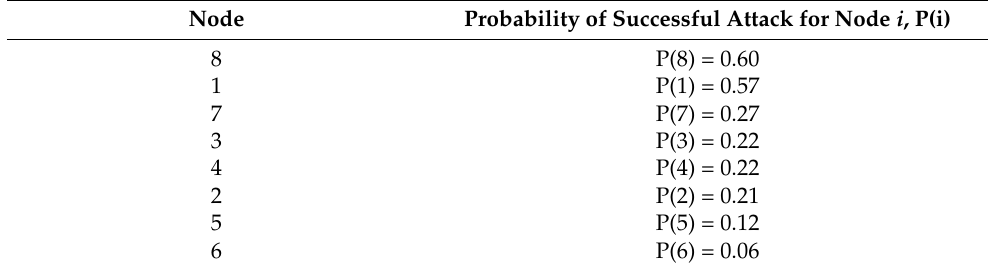
Table 7. Case study probability-based ranking of successful attack in a descending